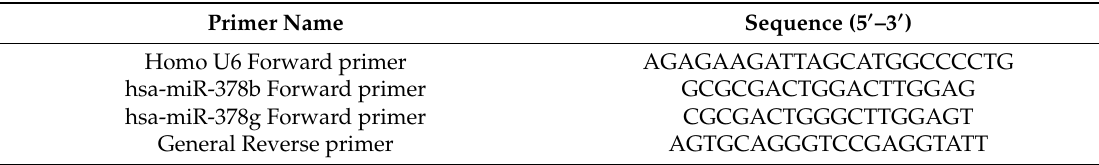
Table 2. List of upstream and downstream primer